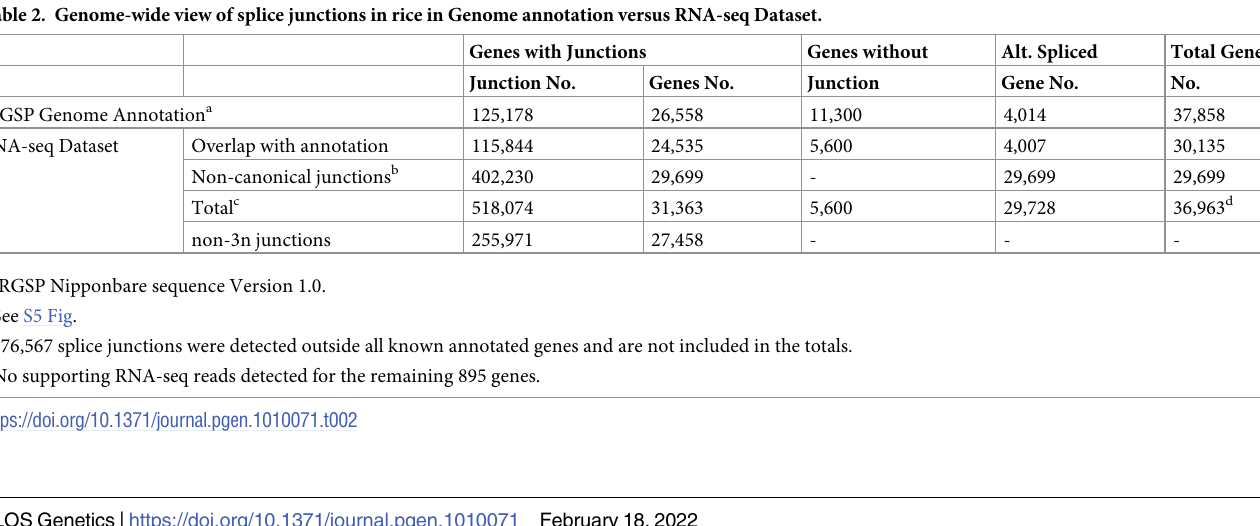
Table 2. Genome-wide view of splice junctions in rice in Genome annotation versus RNA-seq Dataset. Genes with Junctions Genes without Alt. Spliced Total Gene Junction No. Genes No. Junction Gene No. No.